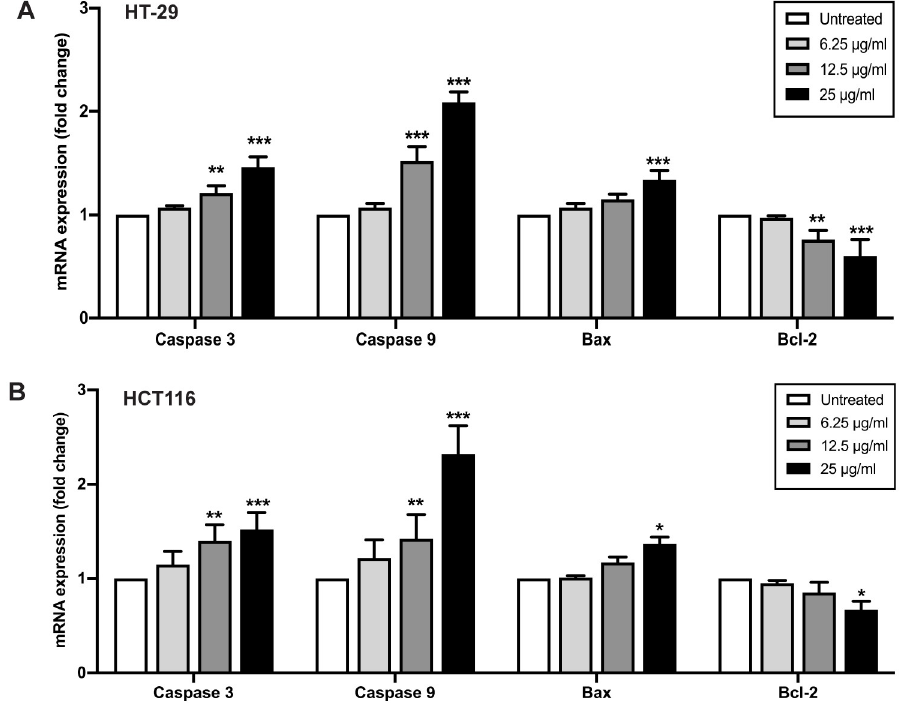
Fig 6. Effect of FDNVs on apoptosis-related genes expression. (A) HT-29 and (B) HCT116 cells were treated with FDNVs for 24 h. The expression of target genes was determined using quantitative RT-PCR. The relative quantitation of each gene was normalized to the constitutive expression of GADPH. The results are mean ± SD of three independent experiments in duplicate and presented as fold change. � P < 0.05, �� P < 0.01 and ��� P < 0.001 compared with untreated cells (one-way